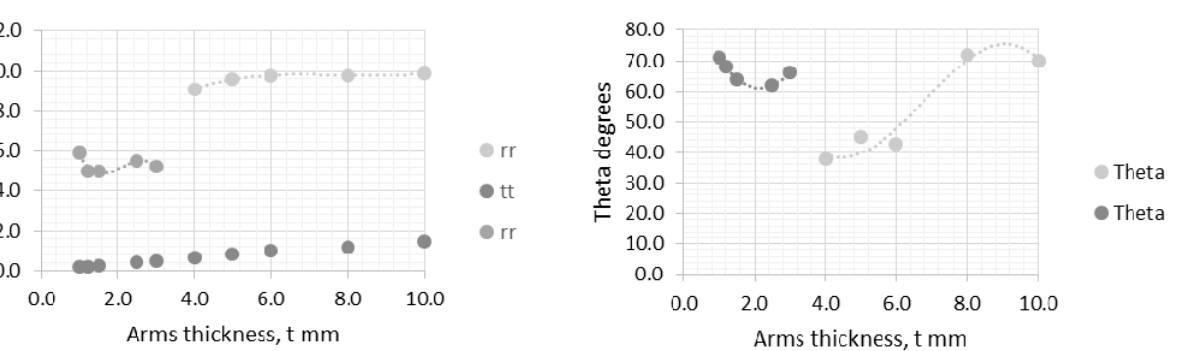
Figure 4: Arms thickness influence on the centre spline radius . Figure 5: Arms thickness influence on the spline exit angle